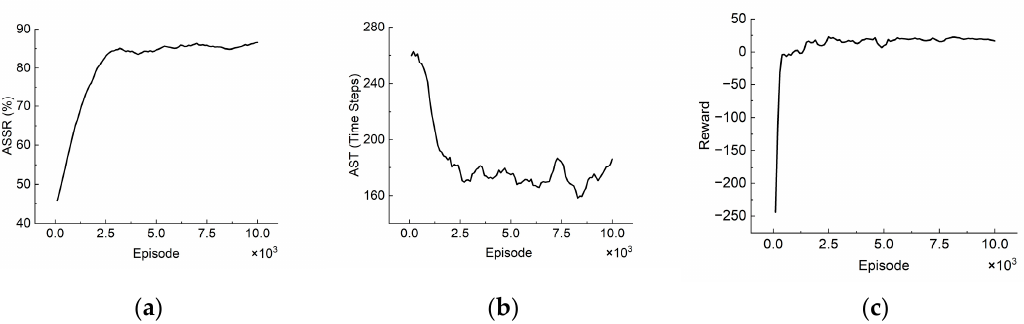
Figure 3. ( a ) ASSR curve, ( b ) AST curve, and ( c ) Reward curve for the MATSMI algorithm.